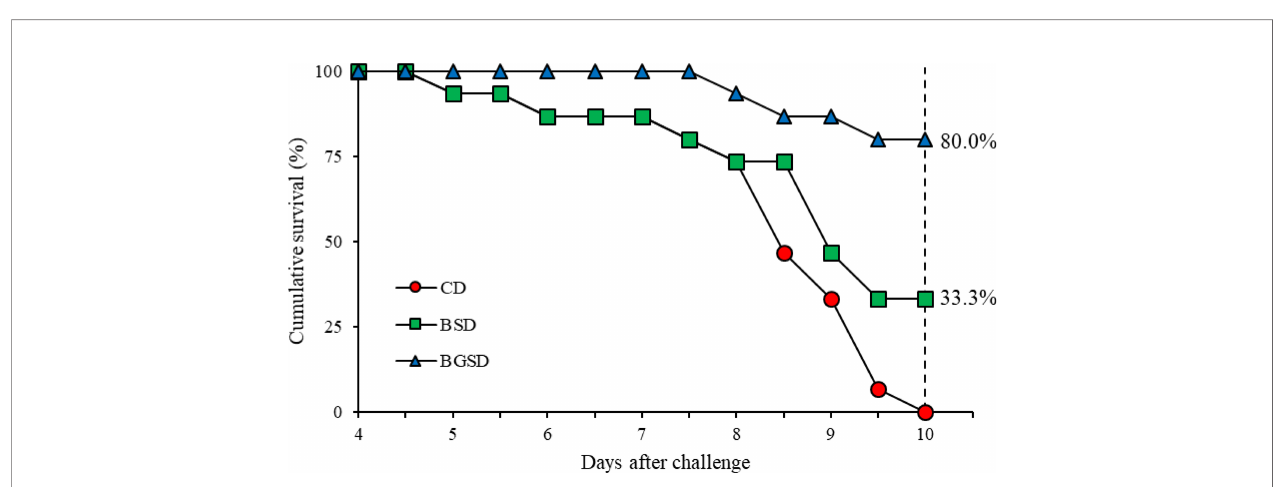
FIGURE 8 | Cumulative survival rates of red sea bream (CD, BSD, and BGSD) challenged with Edwardsiella tarda injection (1 × 10 8 CFU/mL). Means (15 fi sh/group) were compared at identical times. Different letters indicate signi fi cant differences between groups (P < 0.05). Control diet, CD: without Bacillus sp. PM8313 or b -glucan, BSD: 1 × 10 8 CFU g − 1 Bacillus sp. PM8313, and BGSD: BSD + 0.1% b